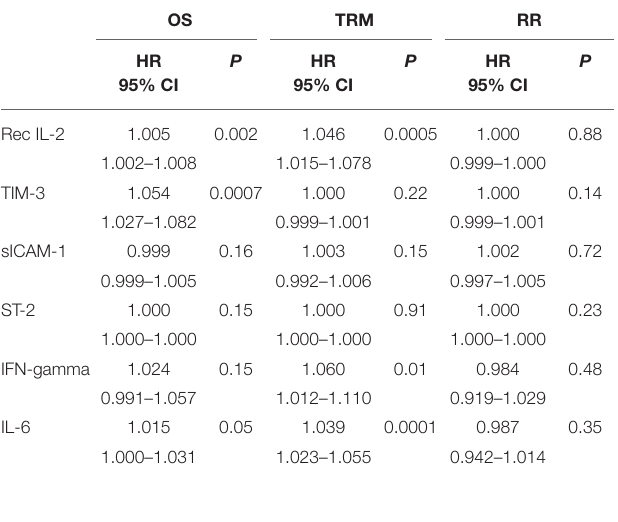
TABLE 3 | Importance of cytokine levels studied as continuous data for OS, TRM, and relapse rate (univariate analysis).